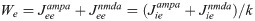
Dynamics of the balanced network with STD and different usage rates for NMDA and AMPA in the EE projections.Positive Δu means higher usage rate for NMDA than AMPA synapses. A: Response of the rate based network with STD to a square pulse imput, beginning at t = 0 and ending at t = 1 s. Parameters are k = 1.2, w = 50, q = 0.5, u = 0.2 and τr = 500 ms. B: Rise time of linear networks for the parameters computed from the time dependent synaptic strengths in panel A using the risetime function from Matlab (The MathWorks, Inc., Natick, MA). For Δu = −0.03, the system is unstable where the blue trace is not shown. C: Temporal trajectories of the network simulated in A as a function of We=Jeeampa+Jeenmda=(Jieampa+Jienmda)/k and Δq. The green circle indicates the starting point of the trajectories while the red circles indicate the end points of the trajectories. The parameters were computed from the STD modulated synaptic strengths at each time point. Shaded areas indicate where the linear system is unstable for the same set of parameters. The AMPA instability corresponds to the left red square in Fig 2D and the NMDA instability to the right red square. Dashed lines indicate parameters where the linear networks have rise times (RTs) of 0.1 s and 1.0 s. D: Response of the LIF network with STD to a square pulse beginning at t = 0 and ending at t = 1 s. Parameter values are k = 0.65, w = 10, q = 0.5, u = 0.2 and τr = 1,000 ms.